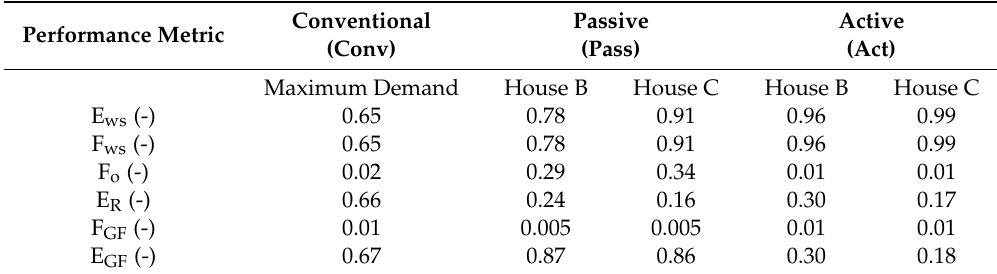
Table 5. Long-term average water supply and stormwater management performance for suggested modelled